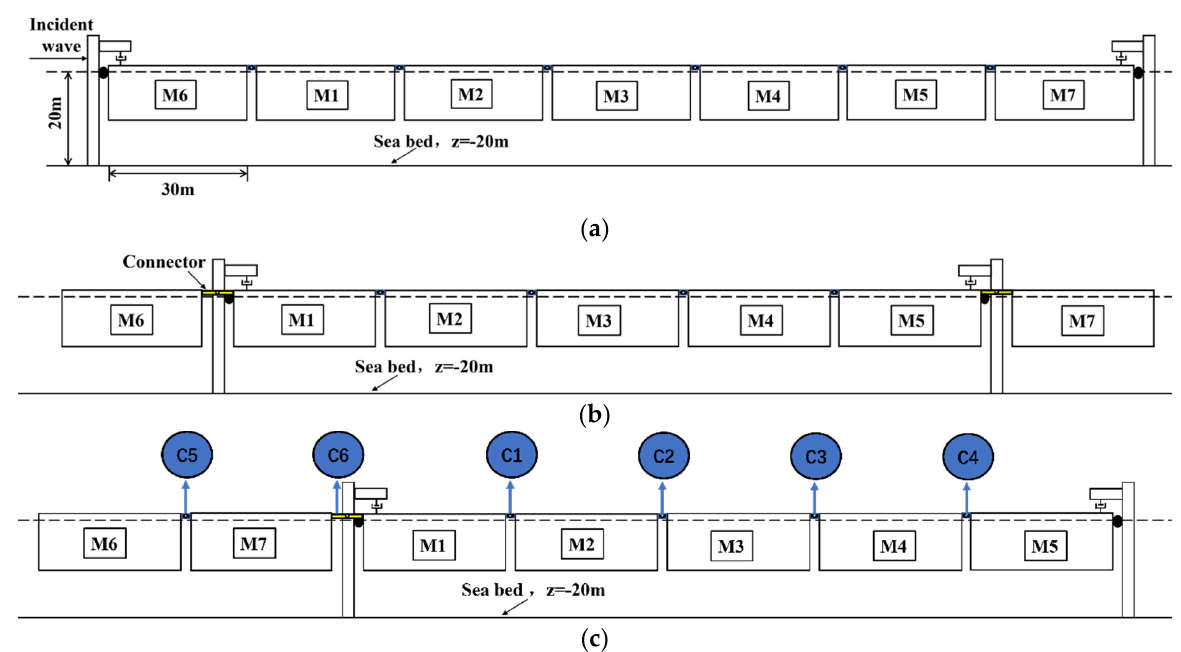
Scheme B: As shown in Figure 8b, two additional modules (M6 and M7) have been expanded symmetrically outside the monopile of the original 5-module MIF system. The